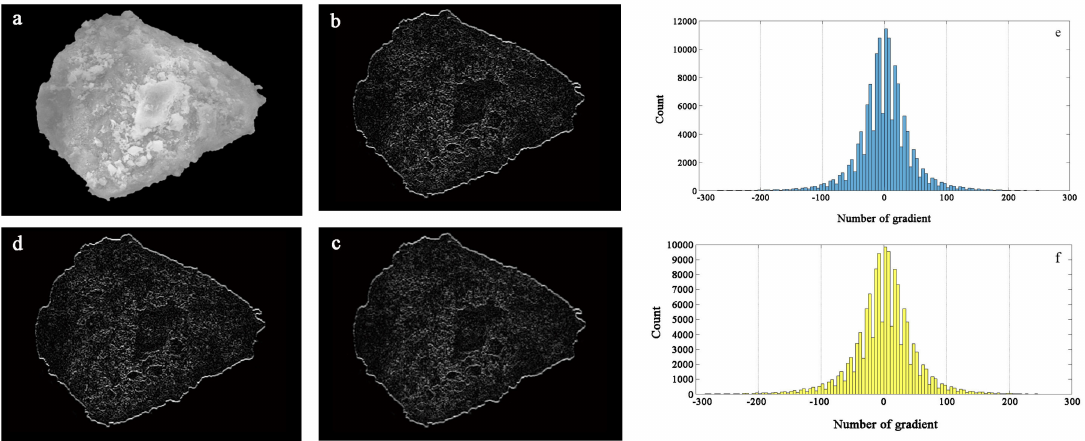
Figure 13. Particle greyscale and amplitude characteristics: ( a ) original greyscale image, ( b ) horizontal gradient of greyscale, ( c ) vertical gradient of greyscale, ( d ) first-order gradient of greyscale, ( e ) horizontal gradient feature, ( f ) vertical gradient